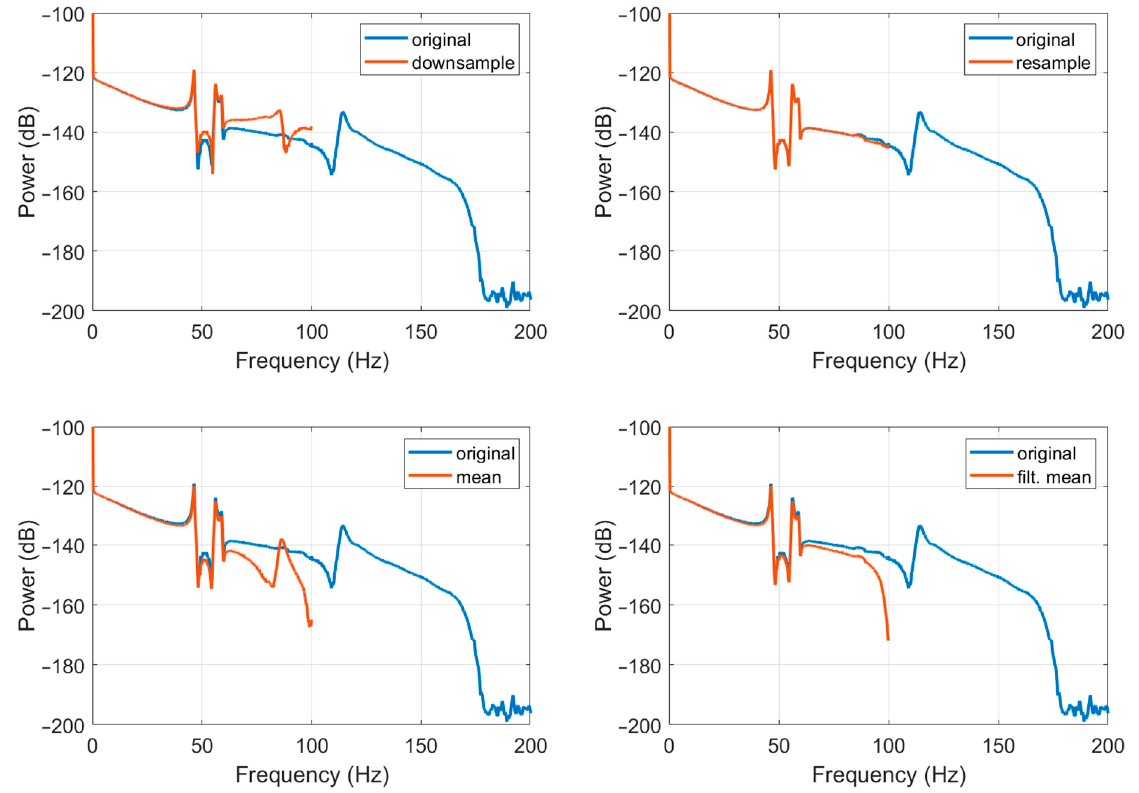
Figure 4. Comparison of the spectral accuracy of different investigated resampling methods based on a simulated spectral signal.